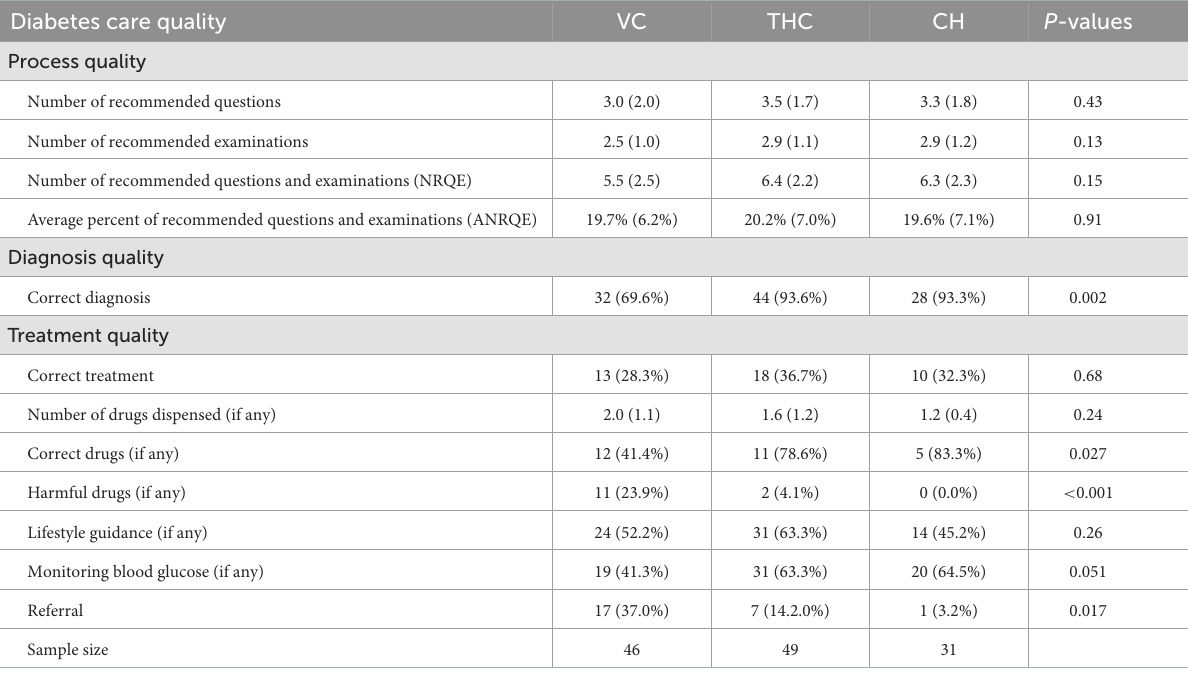
TABLE 2 Quality of type 2 diabetes care among providers from China’s rural healthcare system. Diabetes care